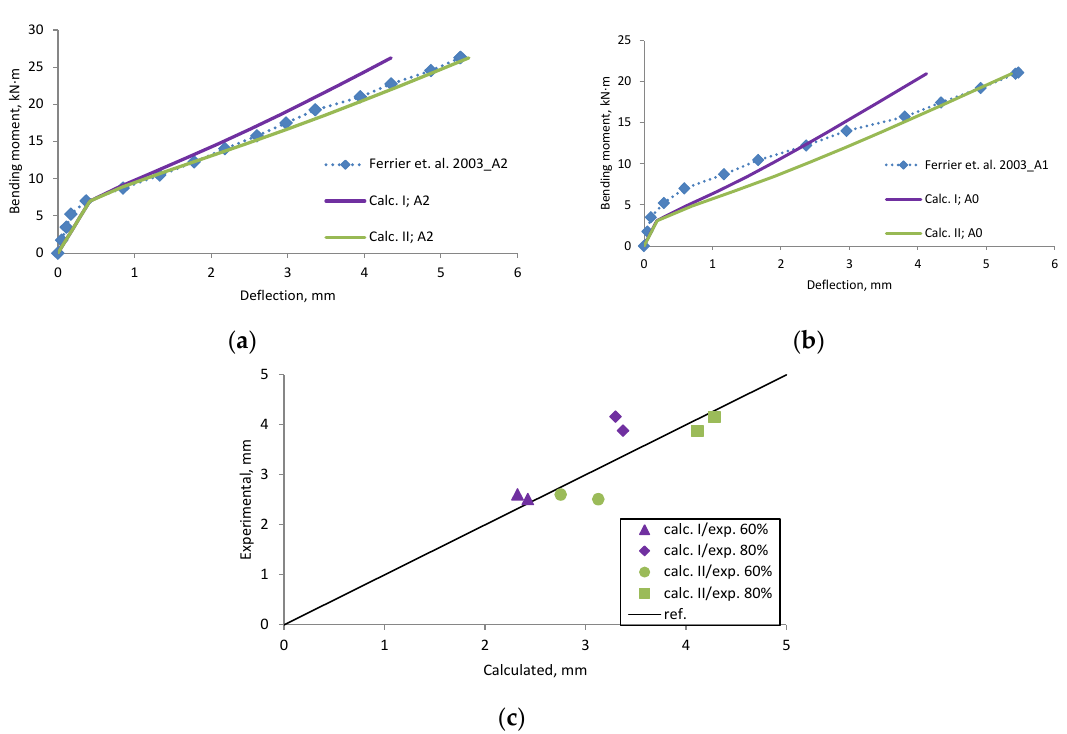
Figure A5. Ferrier et al., 2003 [28] research beams deflection compared with calculated, ( a ) beam A2; ( b ) beam A0; ( c ) scatter of the results at 60% and 80% of the ultimate load.